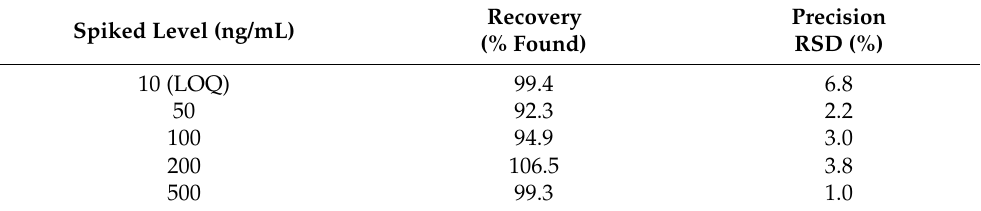
Table 6. The recovery of naftazone from spiked serum samples using SALLE.